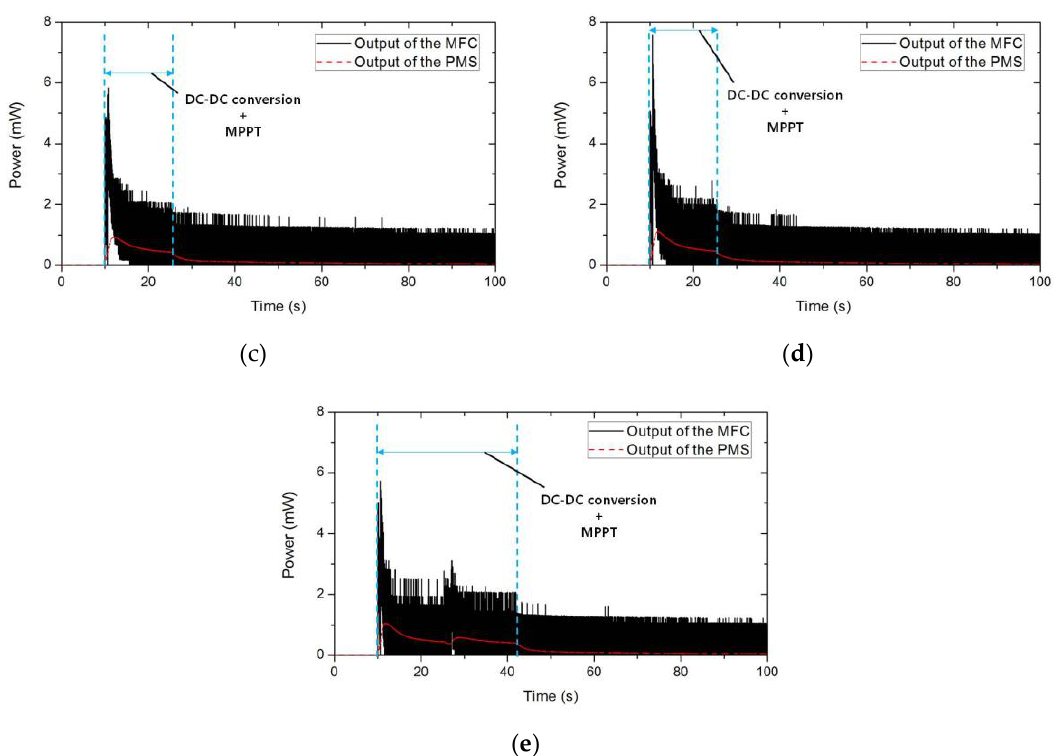
Figure 9. Output powers of the MFC and PMS at different voltage ratios: ( a ) no MPPT; ( b ) MPPT-20%; ( c ) MPPT-40%; ( d ) MPPT-60%; ( e ) MPPT-80%.